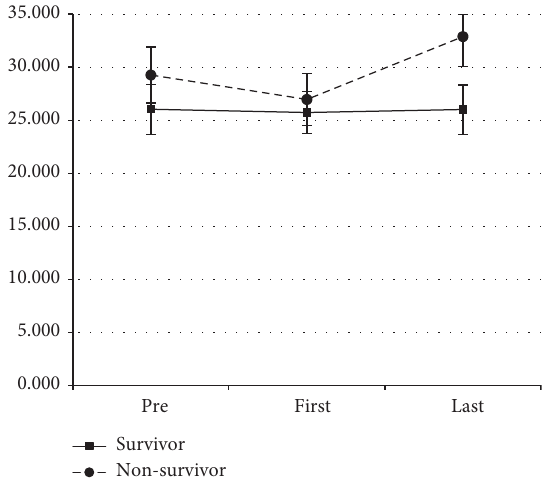
Figure 1: MP and VR measurements in the three prone position moments: preprone, frst prone, and last prone maneuver. MP, mechanical power (in